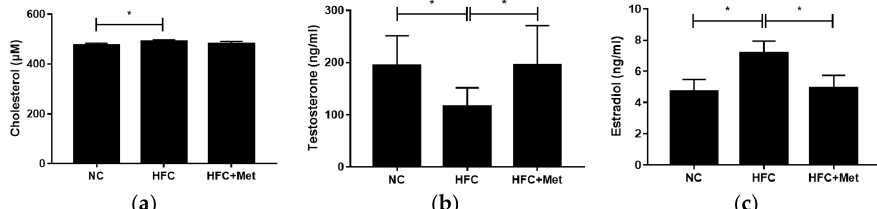
Figure 5. Effects of the high-fat and high-cholesterol diet and metformin supplementation on testicular ( a ) cholesterol, ( b ) testosterone and ( c ) estradiol levels in the male mice: Data are expressed as means ± SD ( n = 5 per group). * p < 0.05 as determined by one-way ANOVA followed by LSD post hoc test. NC, normal diet; HFC, high-fat and high-cholesterol diet; HFC + Met, HFC with metformin supplementation.